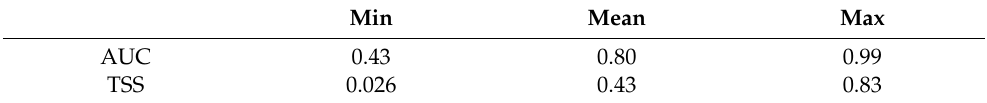
Table 3. Summary of model evaluation for a baseline of 1777 species.